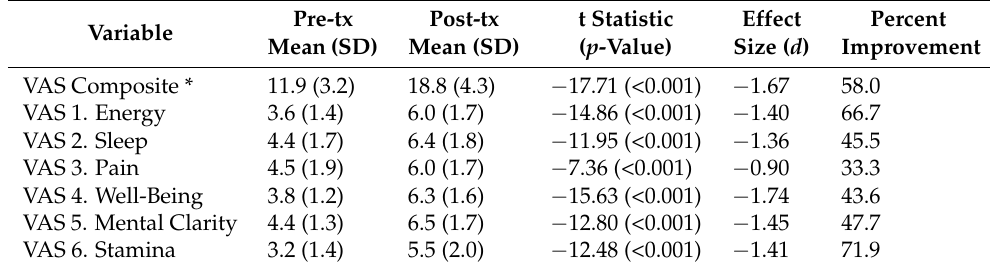
Table 3. Change in VAS Scores Among Subsample Who Self-Reported Improvement ( n =